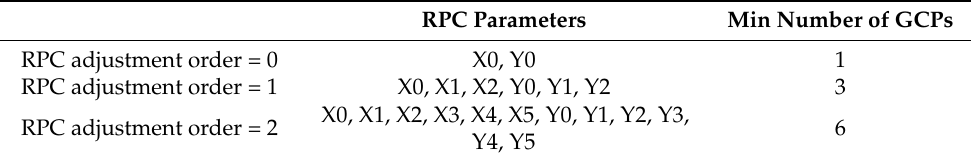
Table 2. Parameters and minimum GCP numbers for RPC refinement in OrthoEngine. RPC